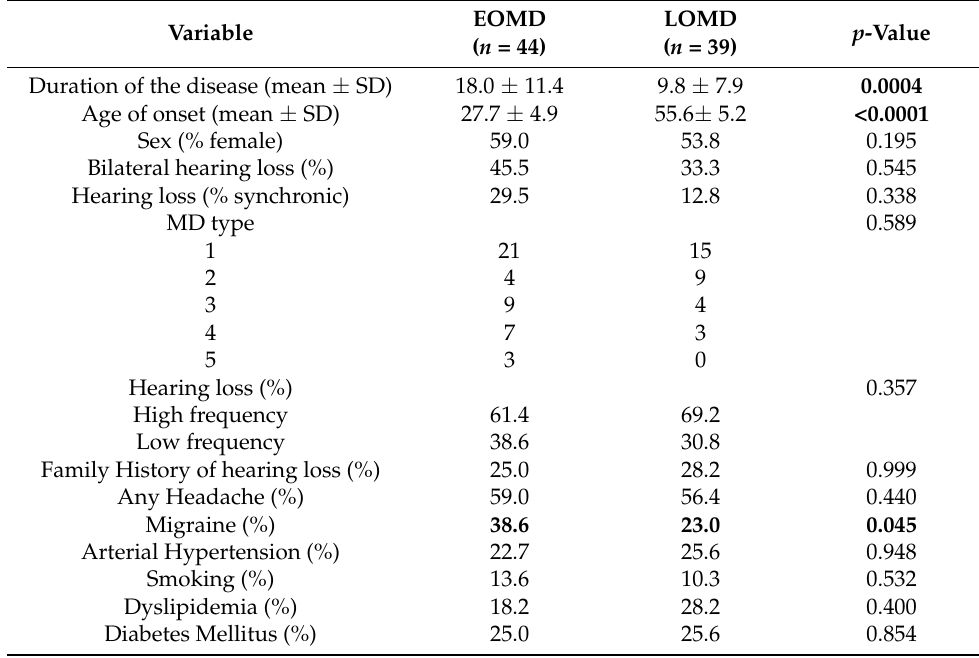
Table 4. Clinical features of patients with EOMD and LOMD included in the study. Migraine was more frequently observed in patients with EOMD. Variable